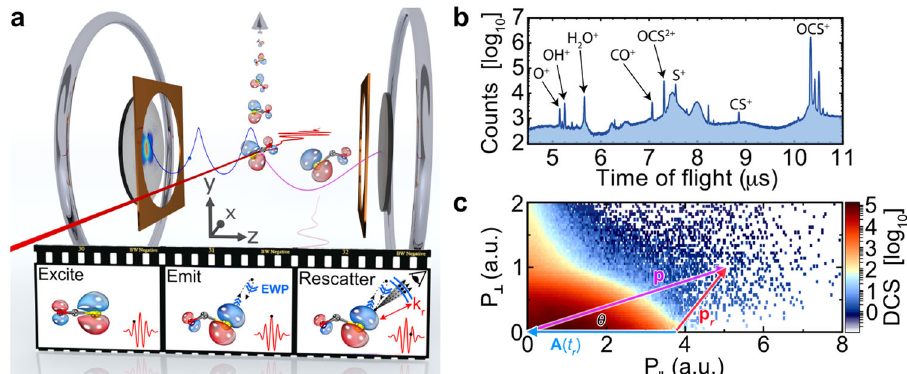
Fig. 1 LIED experimental set-up and analysis. a Schematic of laser-induced electron diffraction (LIED) using a reaction microscope coupled with a mid- infrared OPCPA source. The fi lmstrip inset illustrates the process of imaging the molecular structure with LIED. A molecular jet of OCS molecules is intersected by a 3.2 μ m laser pulse that subsequently excites and emits an electron wave packet (EWP; blue lines in fi lmstrip) before the EWP is returned by the oscillating electric fi eld of the laser pulse and back-rescattered onto the OCS + target molecule. b Measured ion time-of- fl ight (TOF) spectrum. The OCS + molecular ion is the most dominant ion TOF peak. c Two-dimensional map of transverse ( P ? ) and longitudinal ( P || ) electron momentum distribution (i.e. electron momenta emitted perpendicular and parallel, respectively to the laser polarization direction — see Fig. S1) detected in coincidence with OCS + in log 10 scale. The momentum of the electron after elastic collision with the ion is depicted by the vector p (magenta arrow), while p r (red arrow) is the same vector in the laser frame. The two vectors are related by p = − A ( t r ) + p r . In the laser frame, the electron undergoes large-angle elastic scattering and emerges in the direction of p r . The incident electron is along the polarization axis (horizontal axis) moving toward the left-hand side. Upon recollision at time t r , it will gain additional momentum from the laser fi eld given by − A ( t r ) (blue arrow) where A ( t r ) is the vector potential of the laser fi eld. It is convenient to think of the laser frame as equivalent to the centre-of-mass frame in scattering. The elastic scattering occurs in the laser frame, but the rescattered electrons are measured in the laboratory frame. We use θ to measure the laboratory-frame angle from the polarization axis. Thus θ = 0.0° refers to an incident electron that undergoes a 180° backscattering. We consider the laboratory scattering angles of θ = 0.0 – 4.0° in steps of Δ θ = 0.25° to extract the molecular structure. These large-angle (back)scattering events are favourable for probing positions of atoms since they are from collisions at small impact